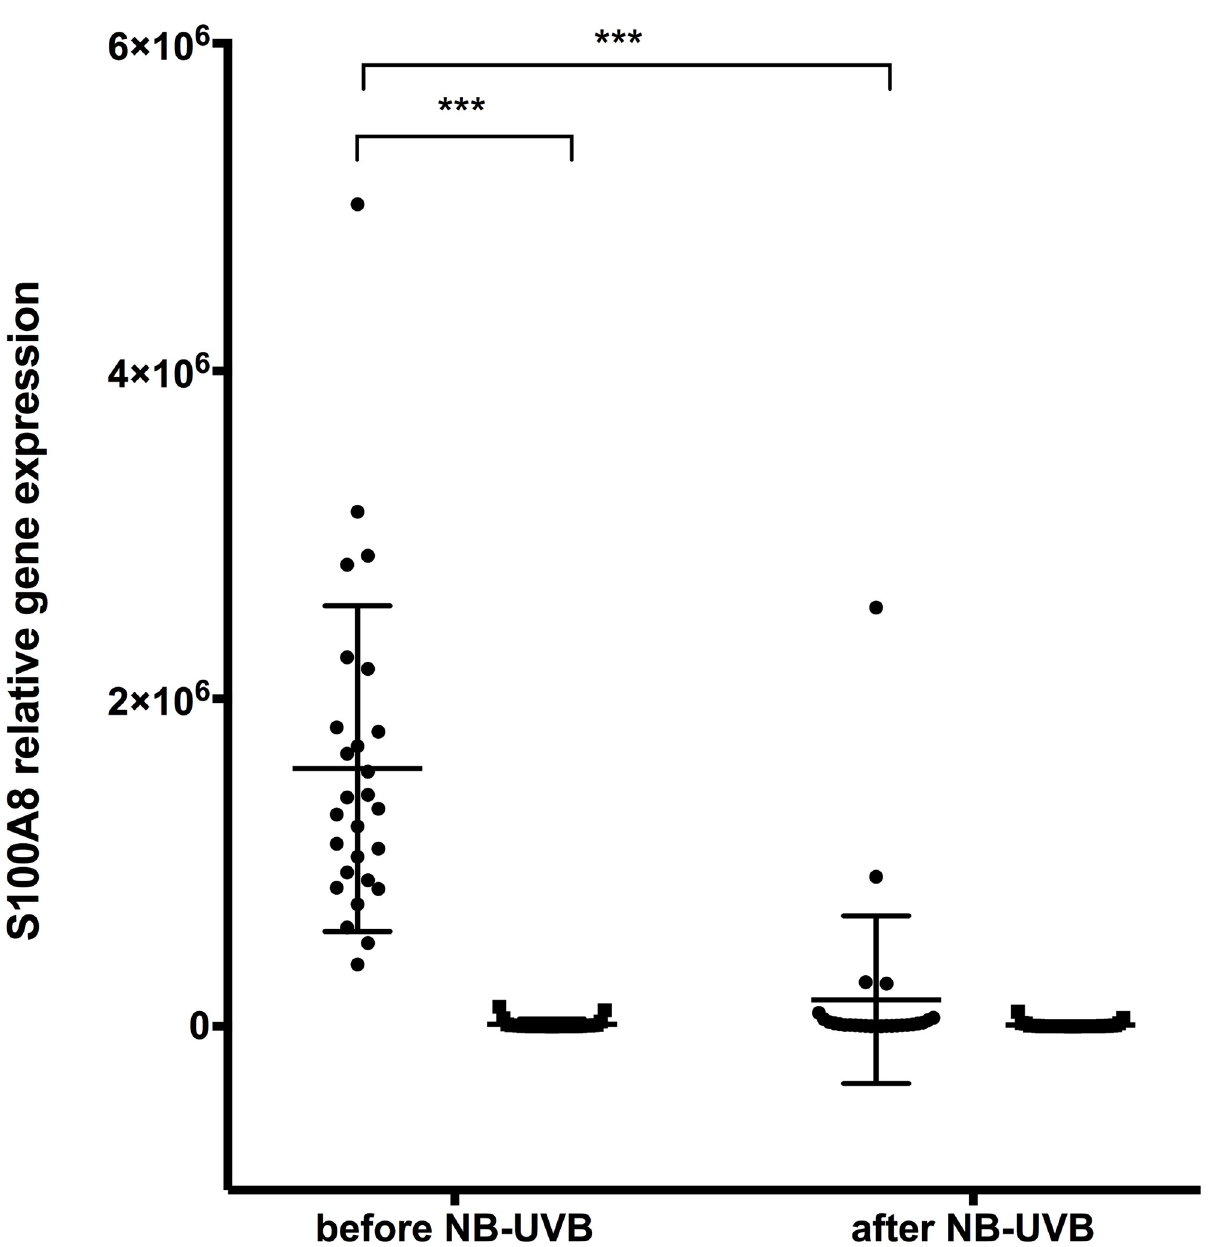
Fig 2. Relative S100A8 gene expression in lesional and non-lesional skin of patients with psoriasis before and after NB-UVB treatment. n = 27, ● = lesional skin, ■ = non-lesional skin. ( ��� p < 0.001).